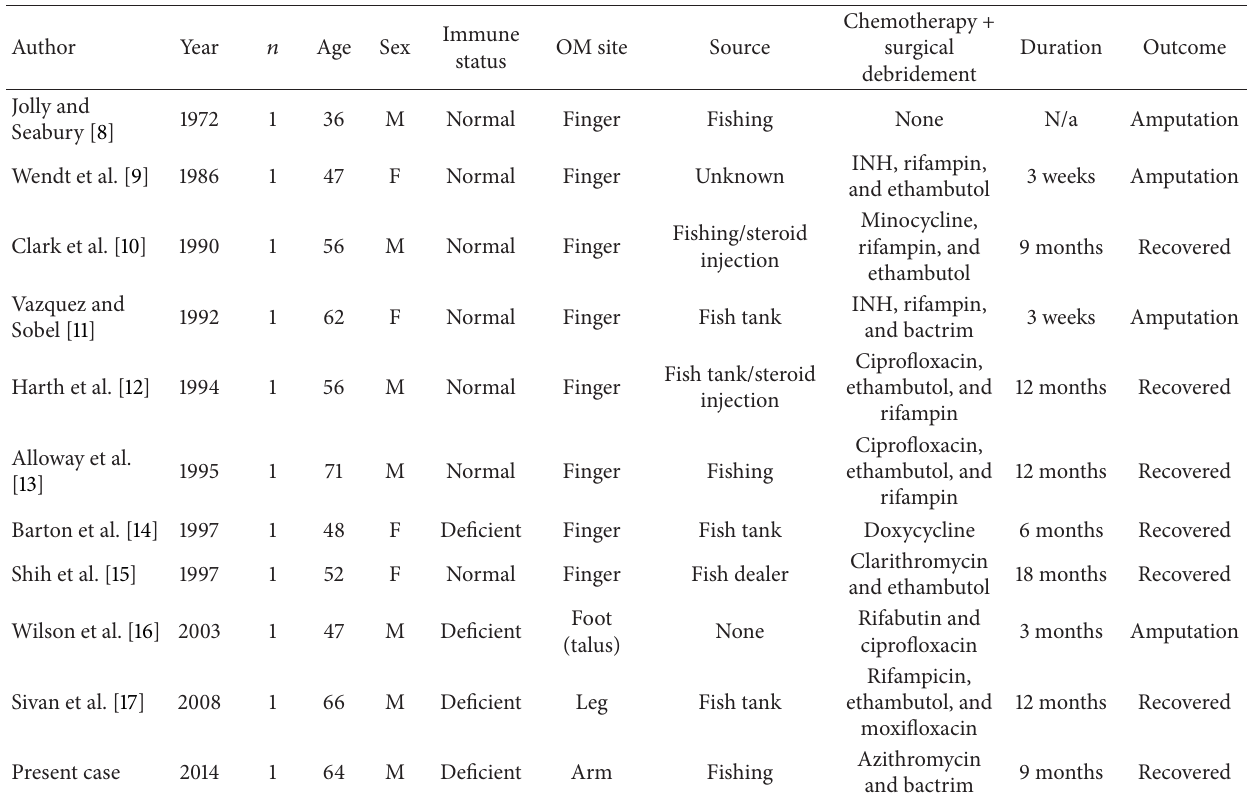
Figure 3: Patient’s left hand at his 9-month follow-up. Table 2: Cases of M. marinum osteomyelitis in the literature review with treatment and clinical